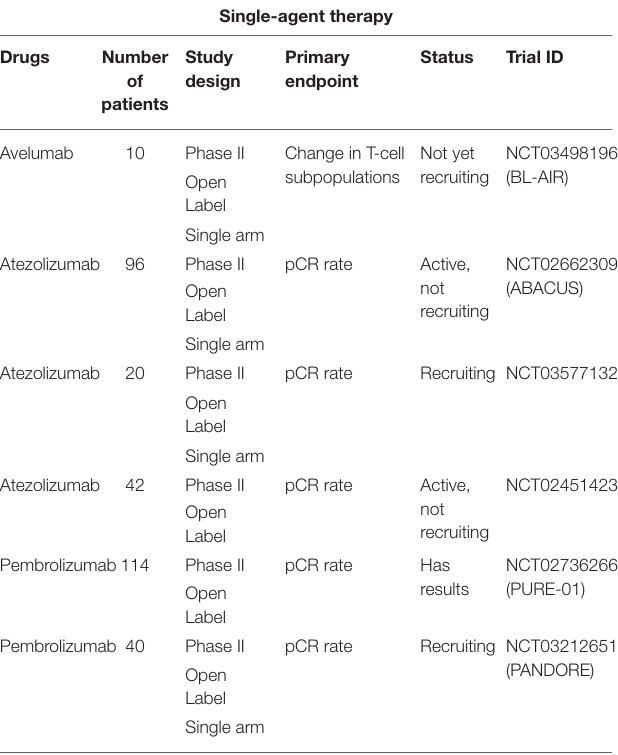
TABLE 1 | Overview of selected neoadjuvant trials in MIBC testing